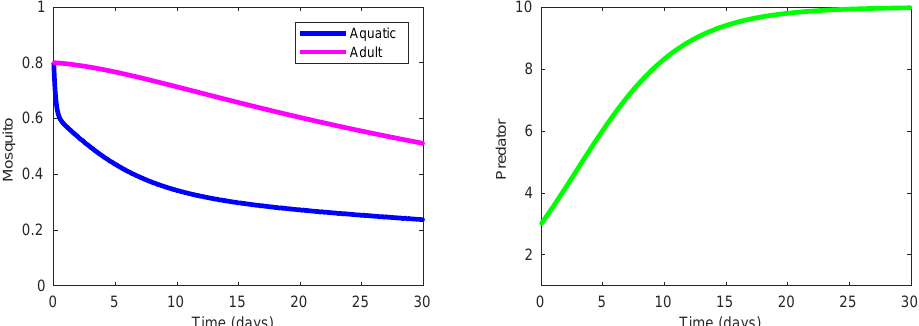
Figure 7. State profiles of the system (1) under Strategy 100: presence of inefficient or inert predator and absence of chemical control